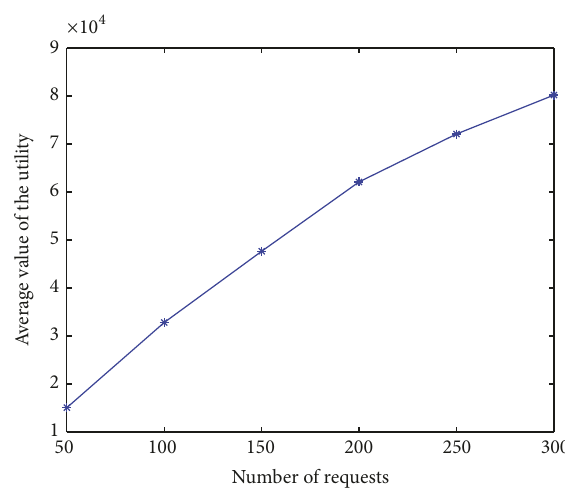
Figure 5: The average values of 𝑈 in HGA for different groups of instances.